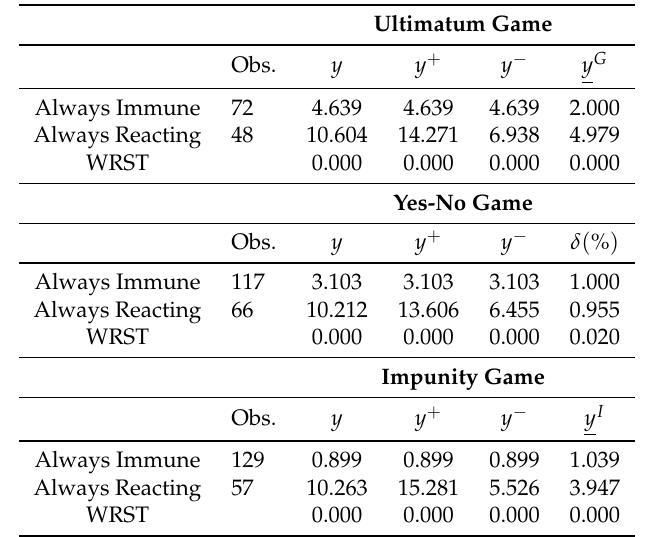
Table 7. Immune and reacting participants average offers and acceptance behavior.